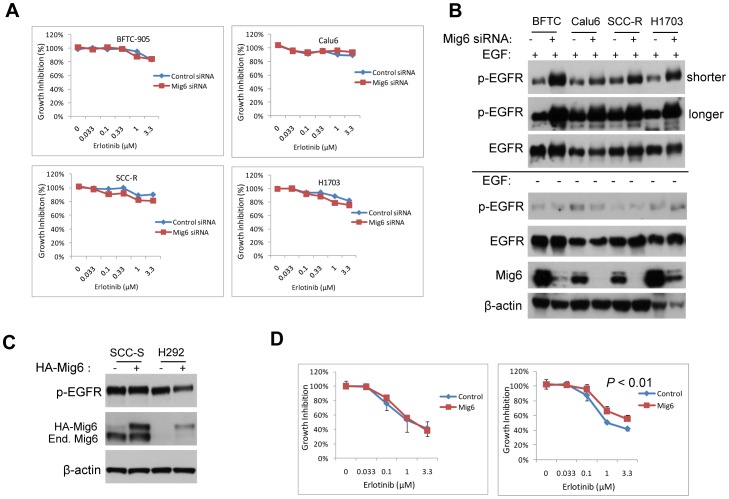
Mig6 knockdown per se did not alter cells sensitivity to erlotinib.
A) Cells were transfected with either control siRNA, or siRNA targeting Mig6 and erlotinib sensitivity assay was performed. B) Cells were transfected with either control siRNA, or siRNA targeting Mig6 and immunoblot blots were performed. C) Cells were infected with MSCV-HA-Mig6 and immunoblot blots were performed. End. Mig6: endogenous Mig6. D) Erlotinib sensitivity was tested in control or HA-Mig6 expressing cells. Data are plotted as mean ± SD and values were set at 100% for untreated controls. * indicates P<0.01.